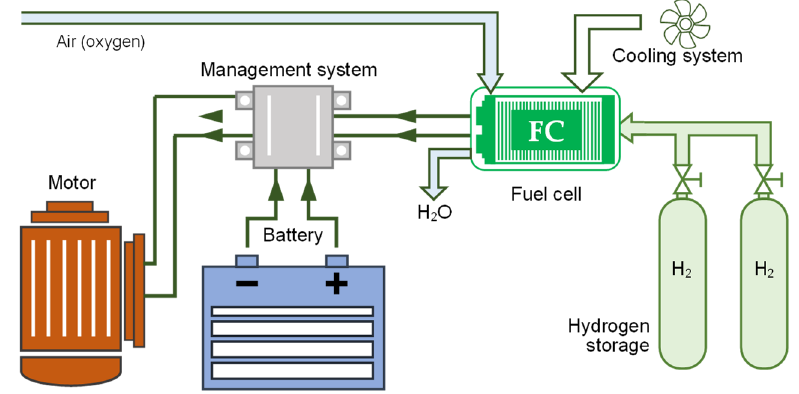
Figure 9. General schematic of the Toyota Mirai drive system.